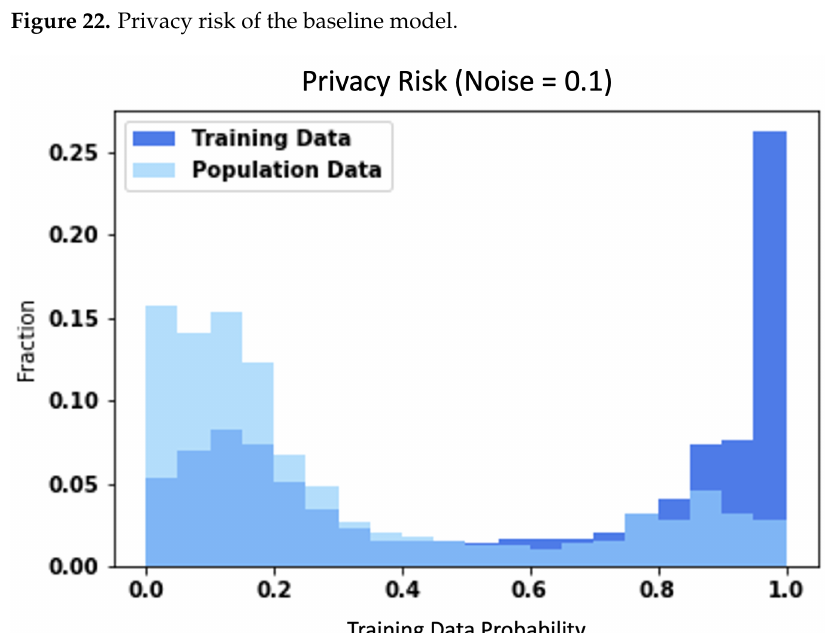
Figure 23. Noise =